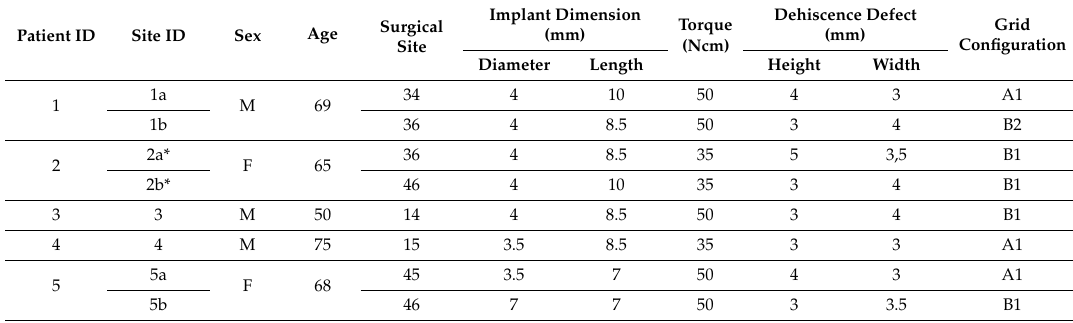
Table 1. Demographic distribution and characteristics of patients and implants based on the surgical sites. *Surgical sites that showed titanium mesh